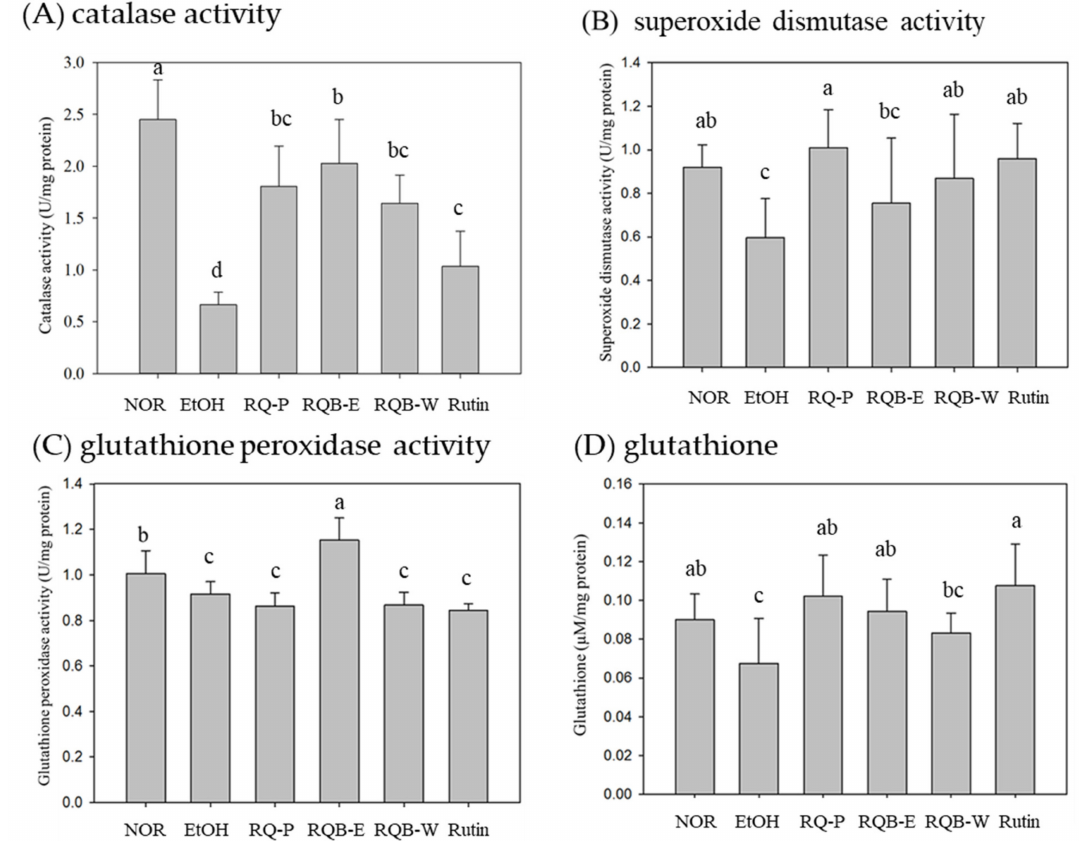
Figure 3. The activities of catalase ( A ), superoxide dismutase ( B ), glutathione peroxidase ( C ), and the levels of glutathione ( D ) in liver. The data are presented as the means ± SD ( n = 8). The means followed by the same letter within each column did not differ significantly from each other ( p > 0.05). However, the means followed by different letter expressed significant difference from each other ( p < 0.05). Two groups of mice were fed with normal liquid diet (NOR group) or ethanol liquid diet (EtOH group) without the administration of test materials, respectively. The other mice fed ethanol liquid diet were administrated with red quinoa powder (5.13 g/kg B.W./day, RQ-P group), red quinoa bran ethanol extracts (1.54 g/kg B.W./day, RQB-E group), red quinoa bran water extracts (1.54 g/kg B.W./day, RQB-W group), and rutin (16.4 mg/kg B.W./day, Rutin